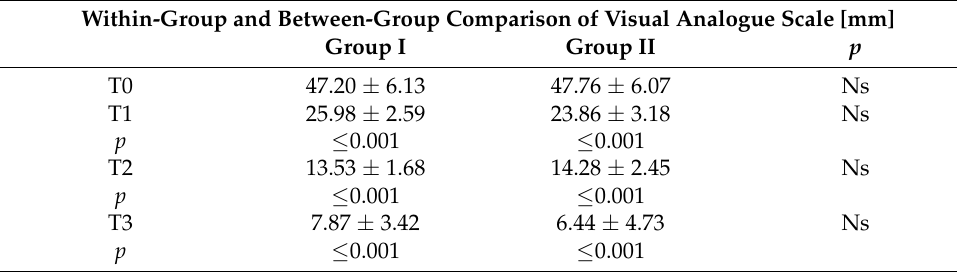
Table 2. Comparison of the pain intensity assessment results obtained in the studied groups between the individual follow-up